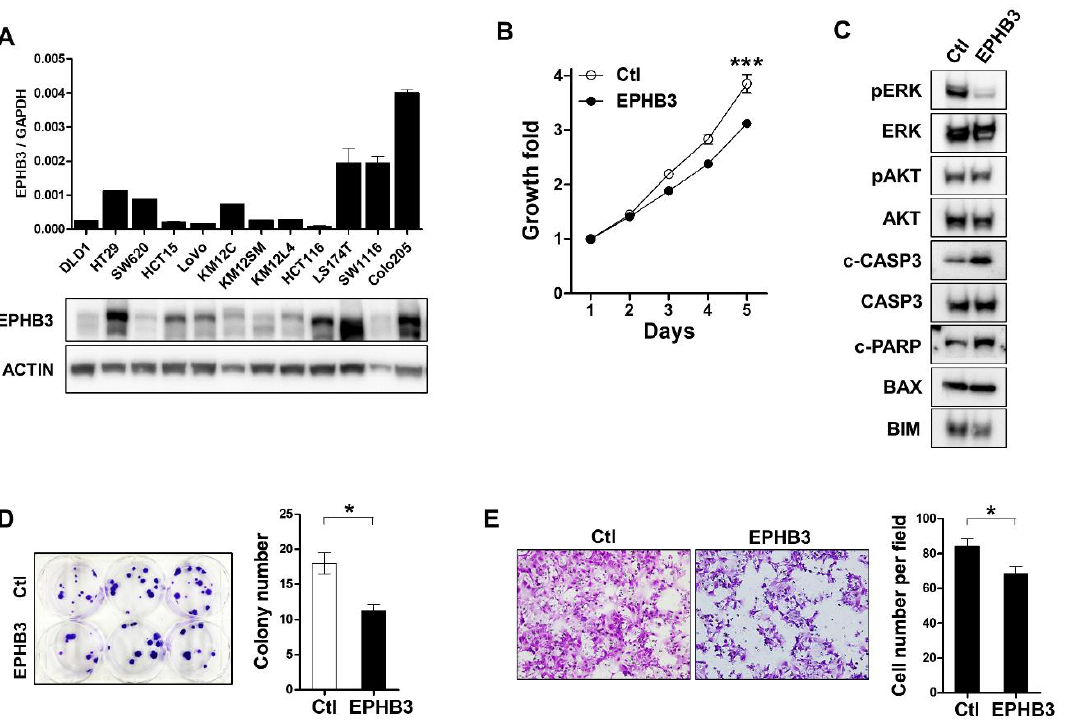
Figure 7. Suppressive effects of EPHB3 on colorectal cancer (CRC) cell growth and migration. ( A ) The mRNA and protein levels of EPHB3 in CRC cell lines were assessed by real-time PCR and immunoblot assays. ( B ) DLD1 was transfected with a control or an EPHB3 expression plasmid, and cells were counted to assess proliferation. ( C ) Twenty-four hours after transfection, immunoblot assays were performed using the indicated antibodies. ( D ) Colony formation assays were performed by counting the number of colonies from control or EPHB3-overexpressing DLD1 cells. ( E ) The effect of EPHB3 expression on the migration of DLD1 cells by transwell migration assay. * p < 0.05, *** p < 0.001. Ctl, control.